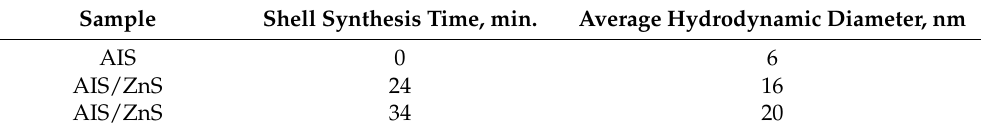
Table 1. Results of QDs size estimation using the Zetasizer Nano ZS analyzer. Sample Shell Synthesis Time,